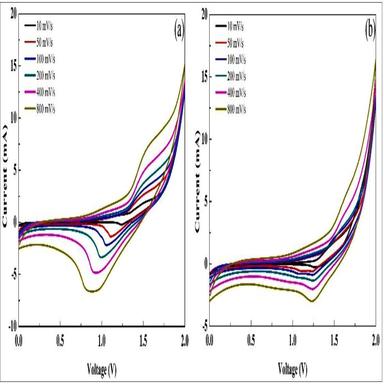
Redox behavior changes with NiCeO2(a), NiCeO2@f-MWCNT/EDA (b).